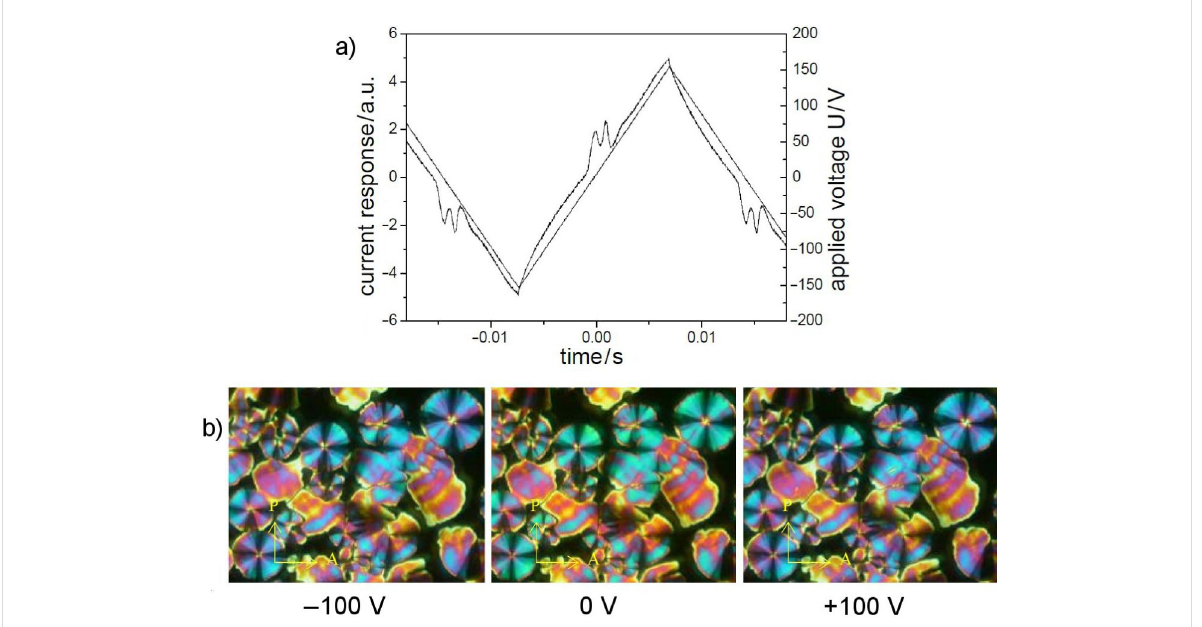
Figure 9: Electro-optical behaviour of compound OH 3a : a) Current response curve ( U = 308 V pp , f = 35 Hz, T = 172 °C, d cell = 6 μ m, P S = 370 nC/ cm 2 ); b) texture of the SmCP A phase depending on the polarity of the applied field.